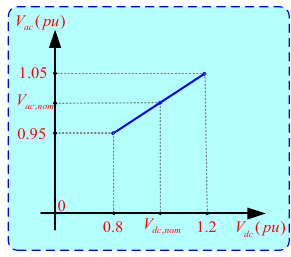
Figure 3. Schematic diagram of the new V DC / V AC droop.